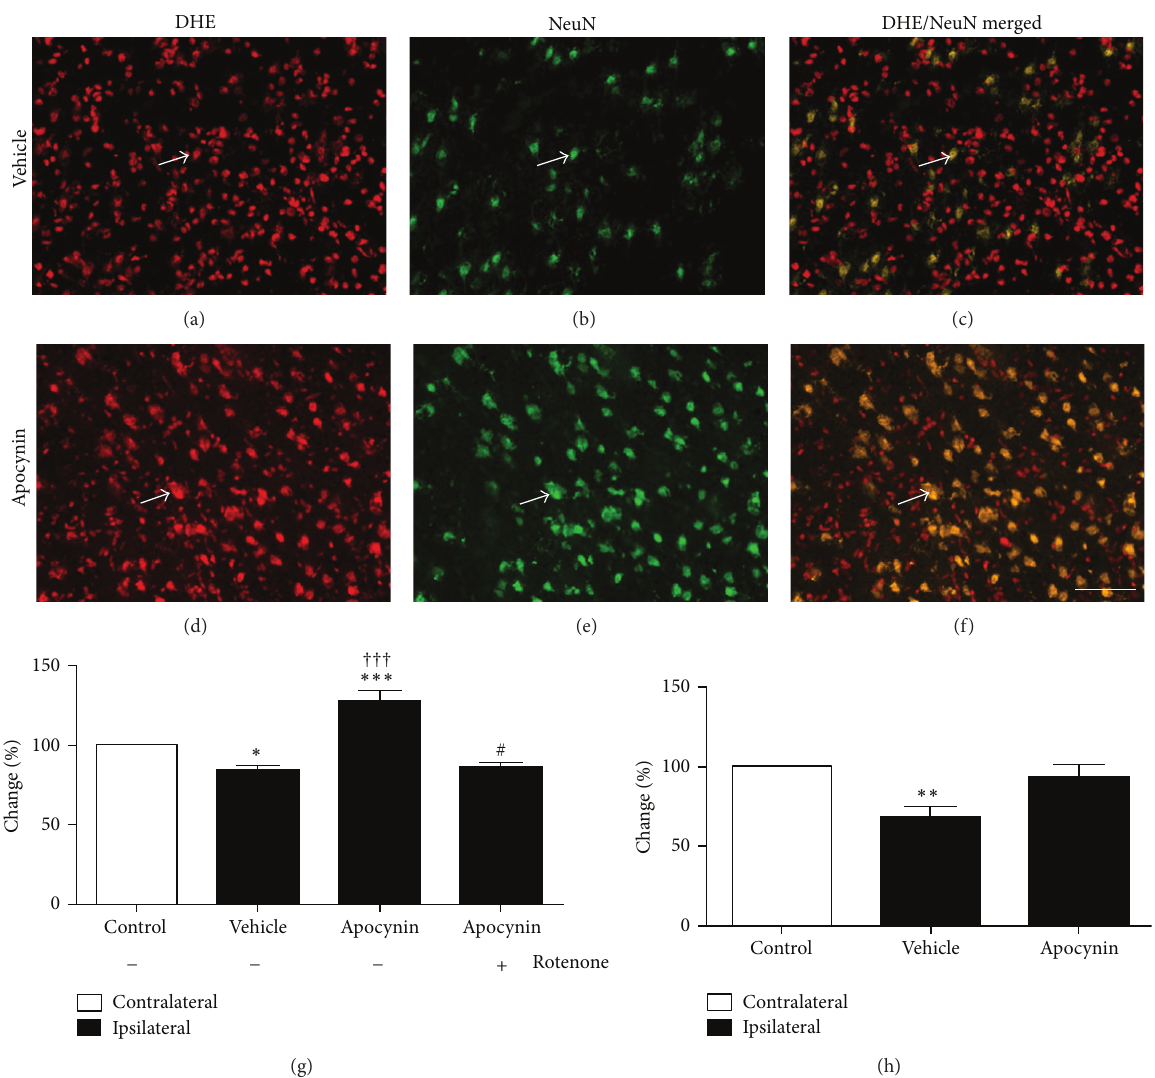
F 5: Immunohistochemical localization of neurons (NeuN) and concurrent superoxide generation (dihydroethidium) in stroke- affected brain following vehicle control ((a)–(c)) and apocynin ((d)–(f)) treatments. Fluorescence micrographs of the ipsilateral cortex with superoxide-sensitive DHE ((a), (d)), the neuronal antibody NeuN ((b), (e)), and merged images ((c), (f)). Arrows point to a typical neuron in the ischemic core. �uanti�cation of neuronal speci�c superoxide release in the core infarct region detected in situ 3 days aer stroke in the ipsilateral cortex (stroke affected; solid bars) compared with the contralateral cortex (nonaffected; open bar) following ischemic stroke in vehicle control; apocynin-treated rats; apocynin-treated rats coincubated in the presence of rotenone in situ (g). �uanti�cation of neuronal speci�c superoxide release in the core infarct region in the ipsilateral striatum compared with the contralateral striatum in vehicle control and apocynin-treated rats (h). Relative �uorescence was �uanti�ed by tracing around cells double labelled with NeuN and analysed